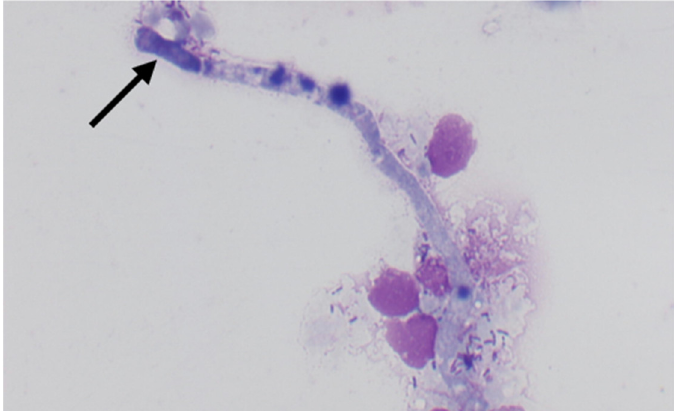
Figure 4. Cytological examination: Neutrophilic inflammation with macrophages with the presence of pigmented septate fungal hyphae (arrowed) ×100.